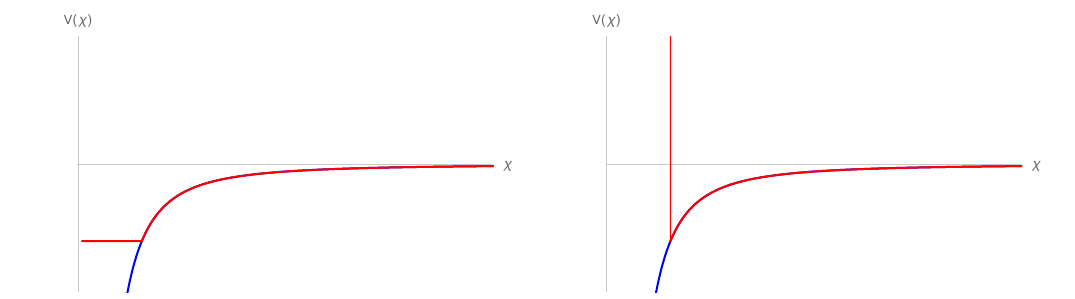
Figure 1 . Inverse square potential and its